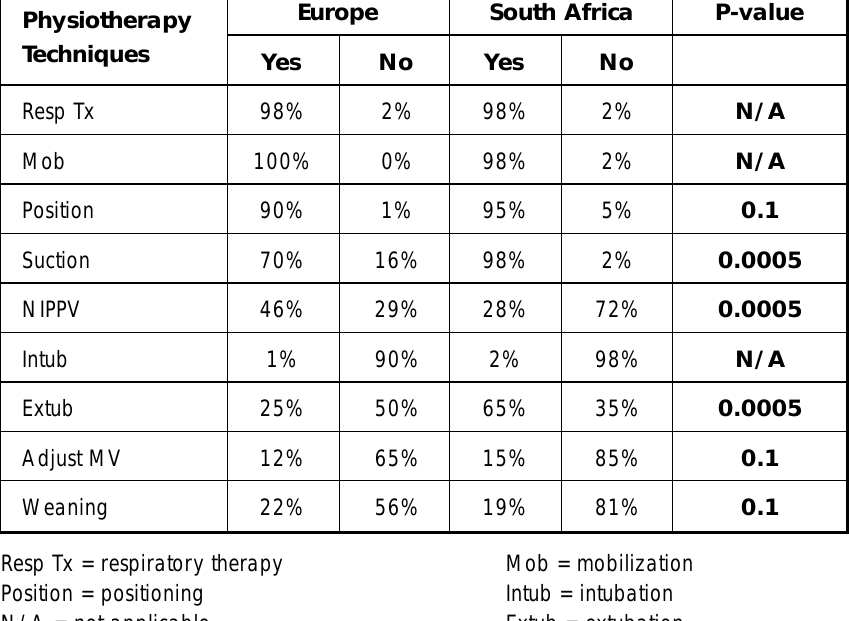
Table 4: Comparison of physiotherapy techniques used by respondents working in ICU between the European and South African